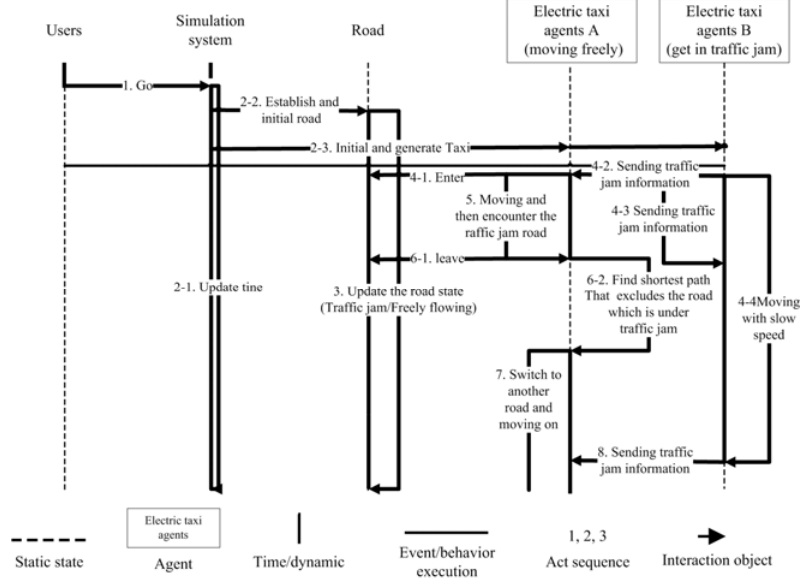
Figure 10. “Incident (traffic jam) interaction